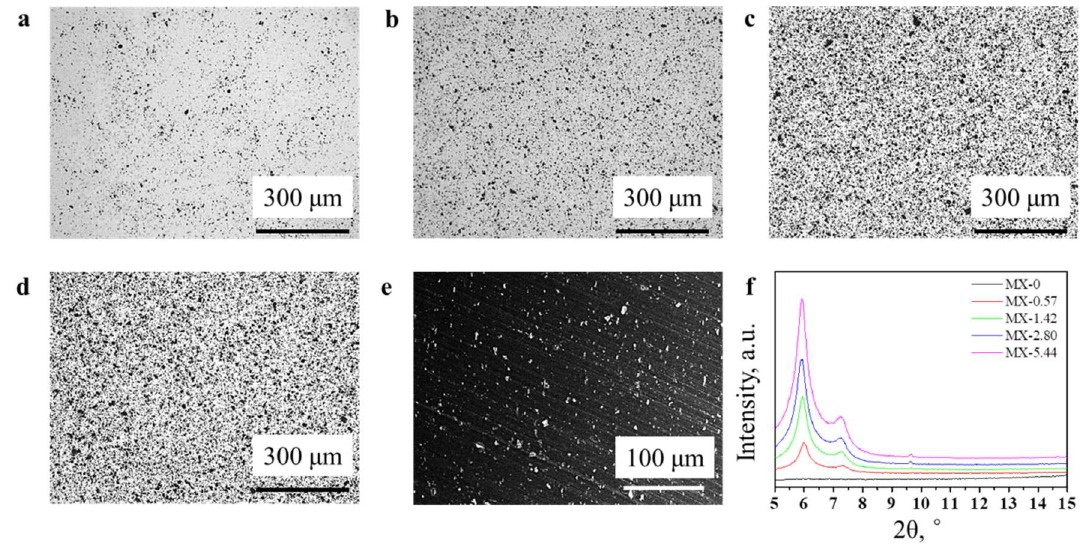
Figure 2. ( a – d ) Optical microscopy images of self-healing coatings containing MXene: ( a ) MX-0.57; ( b ) MX-1.42; ( c ) MX-2.80; and ( d ) MX-5.44; ( e ) SEM image of the fractured surface of MX-2.80; ( f )